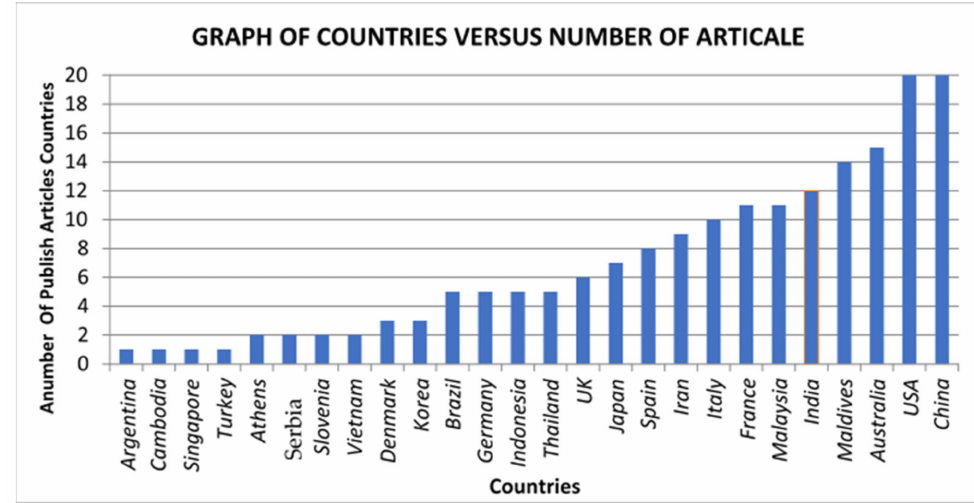
Figure 8. Numbers of included articles based on countries of